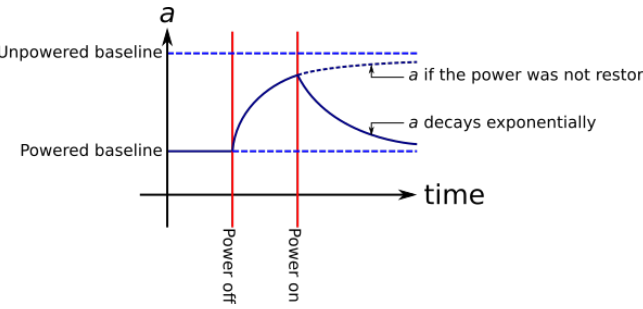
Figure 3. Example curve of net gas adhesion after a power supply interruption event. The a term is the amount of sensor surface area bonded to a target